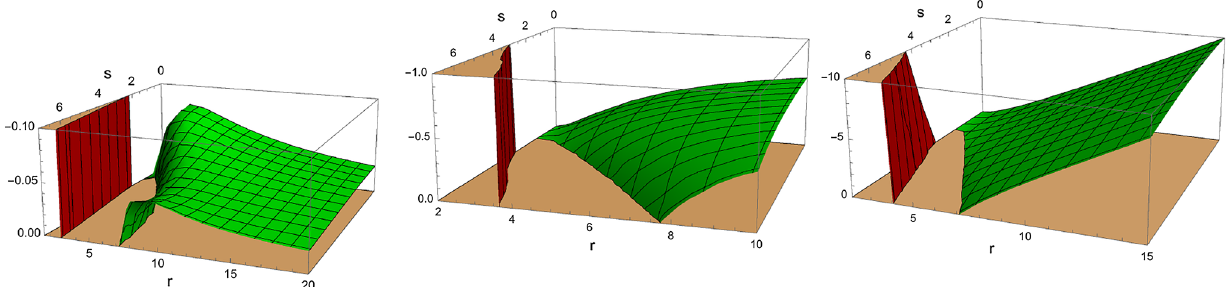
(cid:7) (cid:6) 2 and (cid:9) as a function of r and s , with a 1 = − 2 M , M = 1, b u t